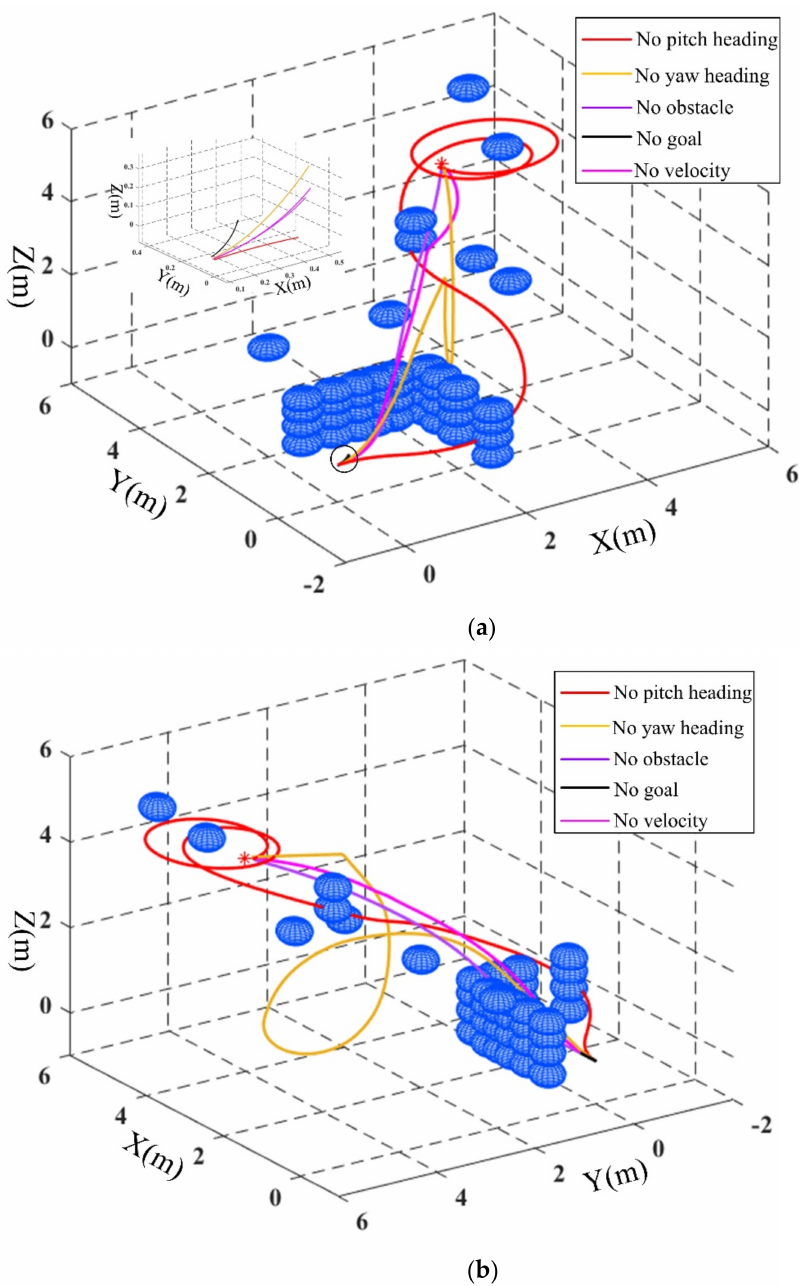
Figure 9. The path planning results with each reward value of the evaluation function being set to zero: ( a ) front view ( b ) side